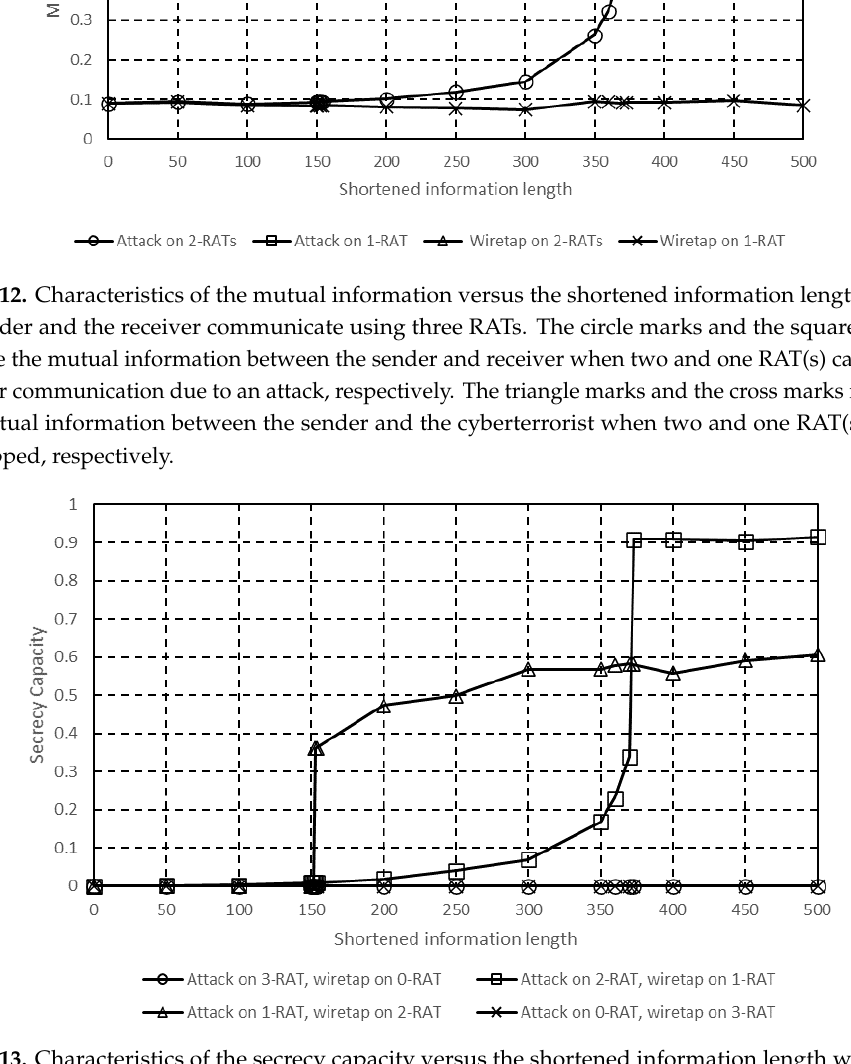
Figure 13. Characteristics of the secrecy capacity versus the shortened information length when the sender and the receiver communicate using three RATs. The circle marks, the square marks, the triangle marks, and the cross marks indicate the secrecy capacity of the cyberterrorist attacking on three RATs, attacking on two RATs and wiretapping on one RAT, attacking on one RAT and wiretapping on two RATs, and wiretapping on three RATs, respectively.